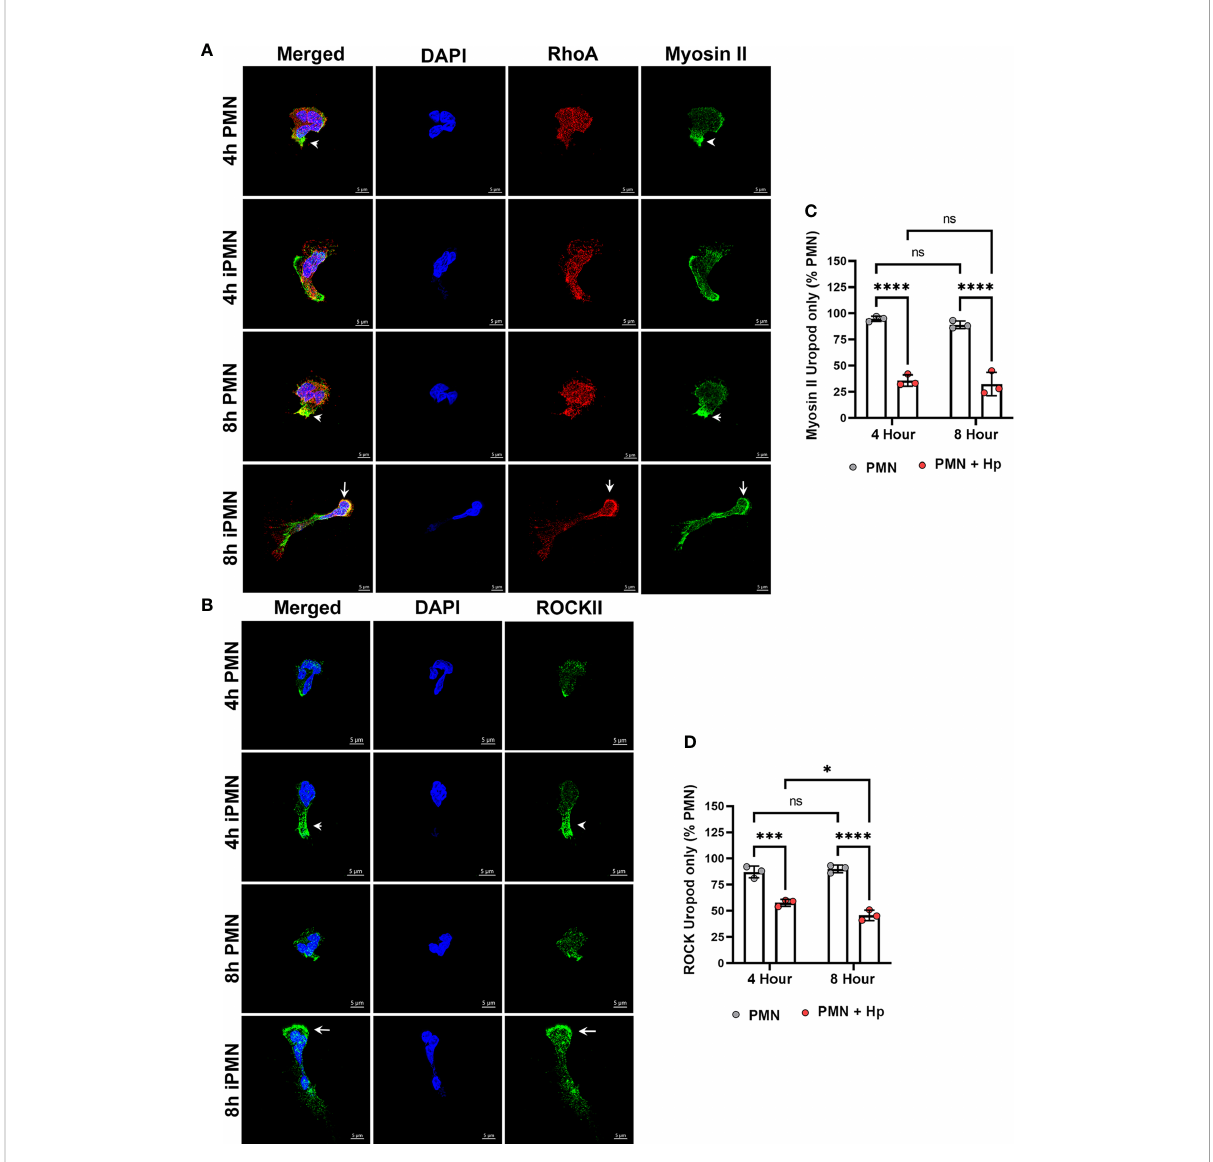
FIGURE 4 RhoA, Myosin II and ROCK II are mislocalized in migrating, infected neutrophils. Cells that migrated toward fMLF in MatTek ™ dishes at 4 or 8 hours were fi xed and processed for confocal microscopy. (A) Z-stack images of control and infected PMNs (iPMNs) (were stained to detect DNA (DAPI, blue), RhoA (red) and myosin IIA (green). Arrowheads indicate myosin II enrichment at the uropod of control PMNs. Arrows indicate accumulation of RhoA and myosin IIA at the front of 8 hour iPMNs. (B) Z-stack images of control and infected PMNs were stained to detect DNA (DAPI, blue) and ROCK II (green). Arrowheads indicate ROCK II accumulation in the elongated uropod of a 4 hour infected PMN (iPMN). Arrows indicate ROCK II accumulation at the leading edge of an 8 hour iPMN. Images shown are representative of three independent experiments. Scale bar = 5 m m. (C, D) Pooled confocal data indicate the percentage of uninfected and H . pylori -infected PMNs that exhibited myosin II staining con fi ned to the uropod (C) or ROCK II staining con fi ned to the uropod (D) . At least 100 cells/experiment/condition were scored. Data are the mean ± SD from three independent experiments. Data were analyzed by two-way ANOVA and Tukey ’ s multiple comparisons post-test. * p <0.05, *** p <0.001, **** p <0.0001, ns, not signi fi cant, as indicated. Hp, H . pylori